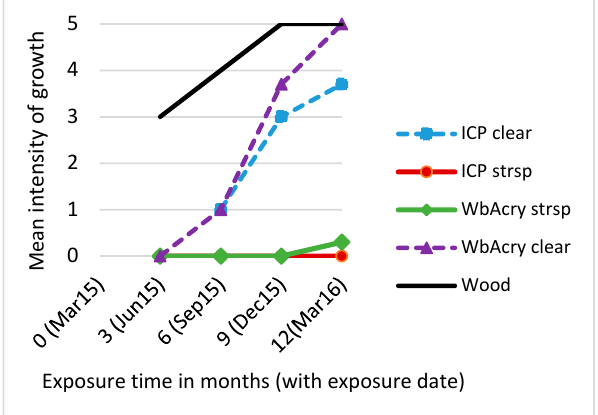
Figure 3. Intensity of fungal growth (EN 16 492) on panels versus exposure time.